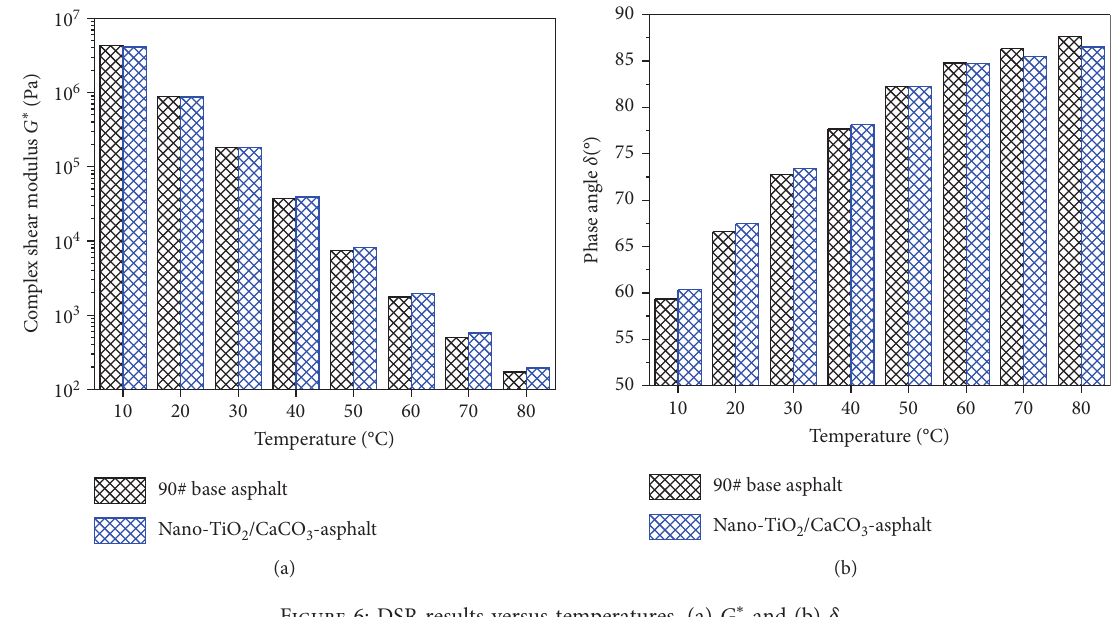
2 /CaCO 3 -modified bitumen.